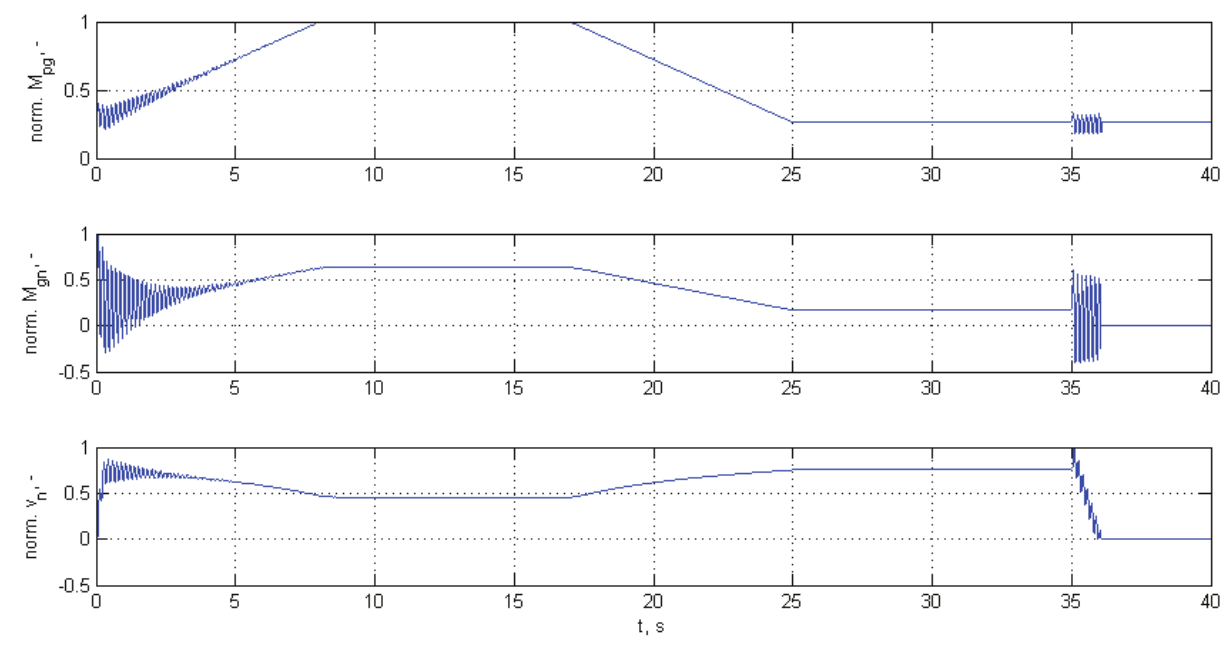
Fig. 8. Results of simulation following the scenario: run-up with loading of excavated material, unloading, run-down